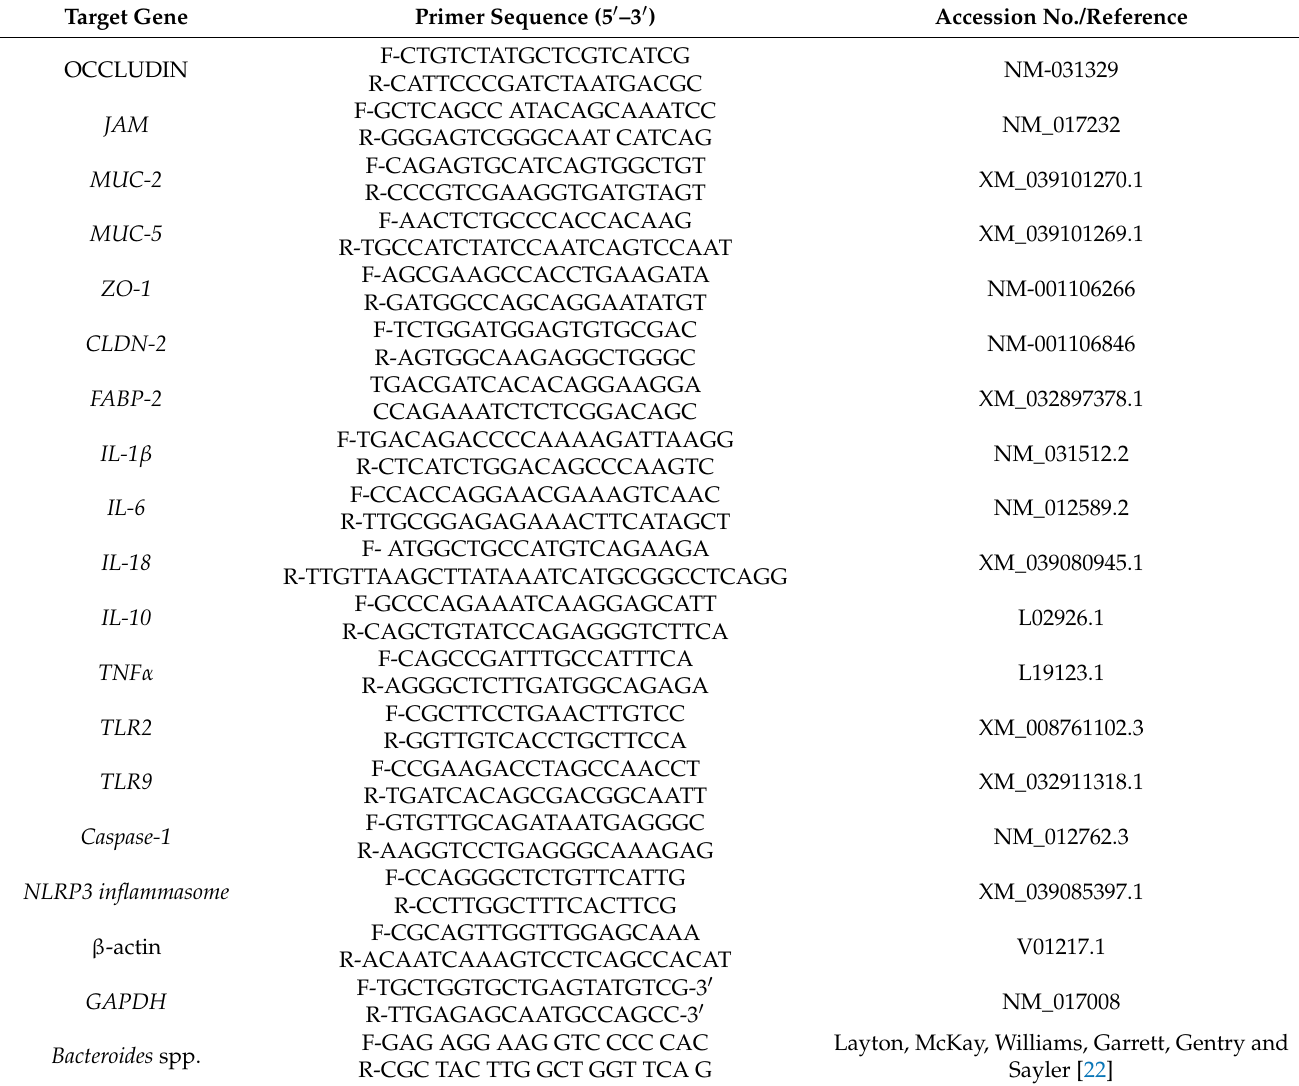
Table 2. Primer sequences utilized for the qRT-PCR analysis of targeted gene